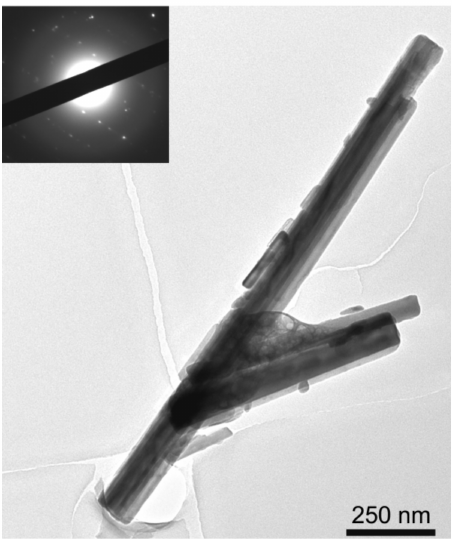
Figure 12. TEM image of crocidolite and corresponding SAED pattern after 10 min of